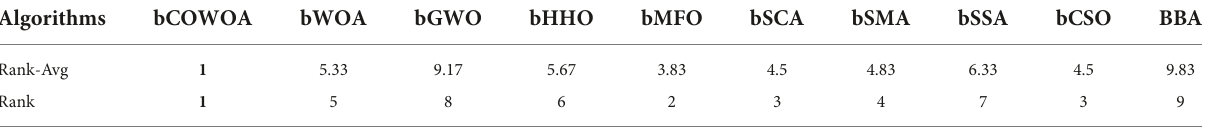
TABLE 17 Average classification accuracy ranking.